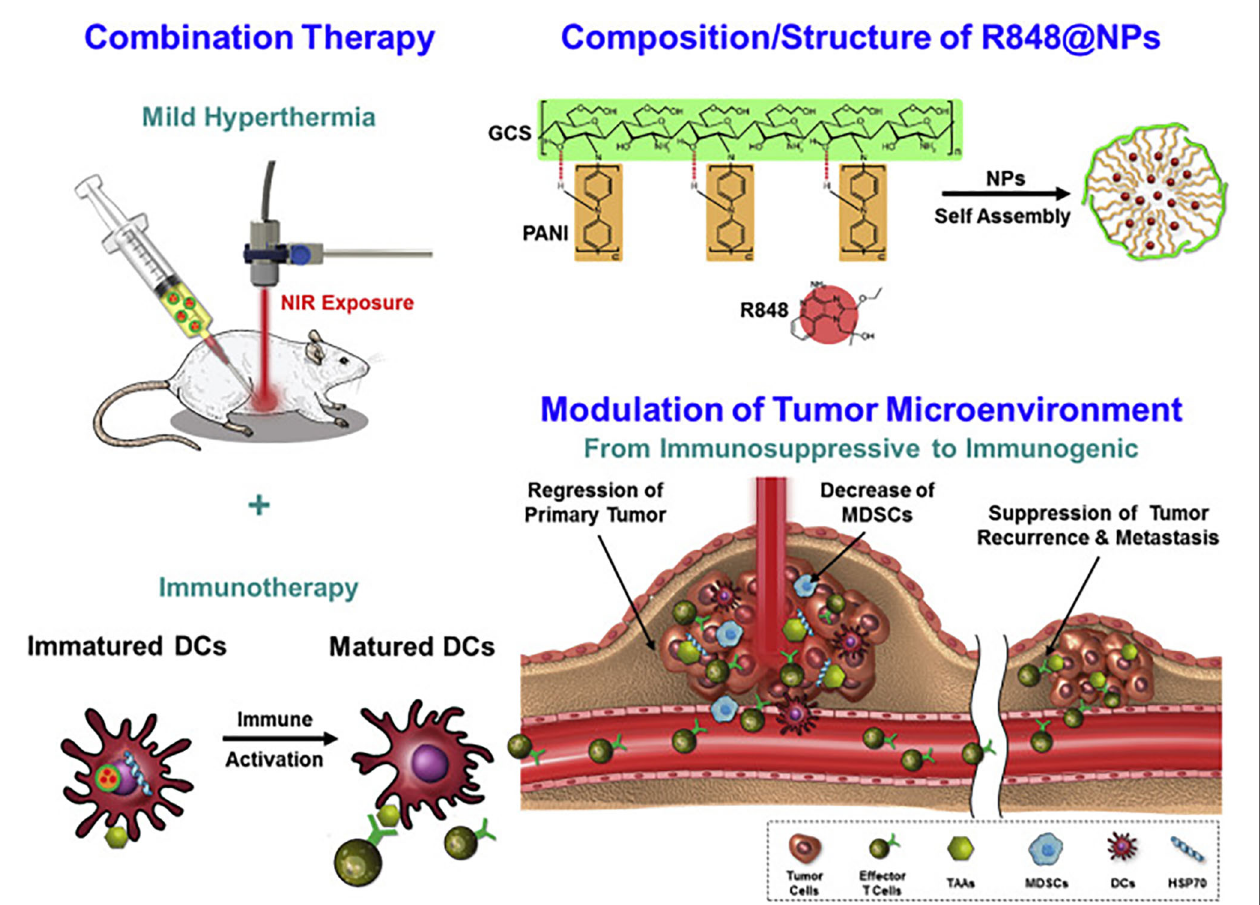
FIGURE 6 | Design of photo-ablative and immunomodulating chitosan-based nanoparticles based on the activity of polyaniline and R848. Reprinted with permission from Elsevier